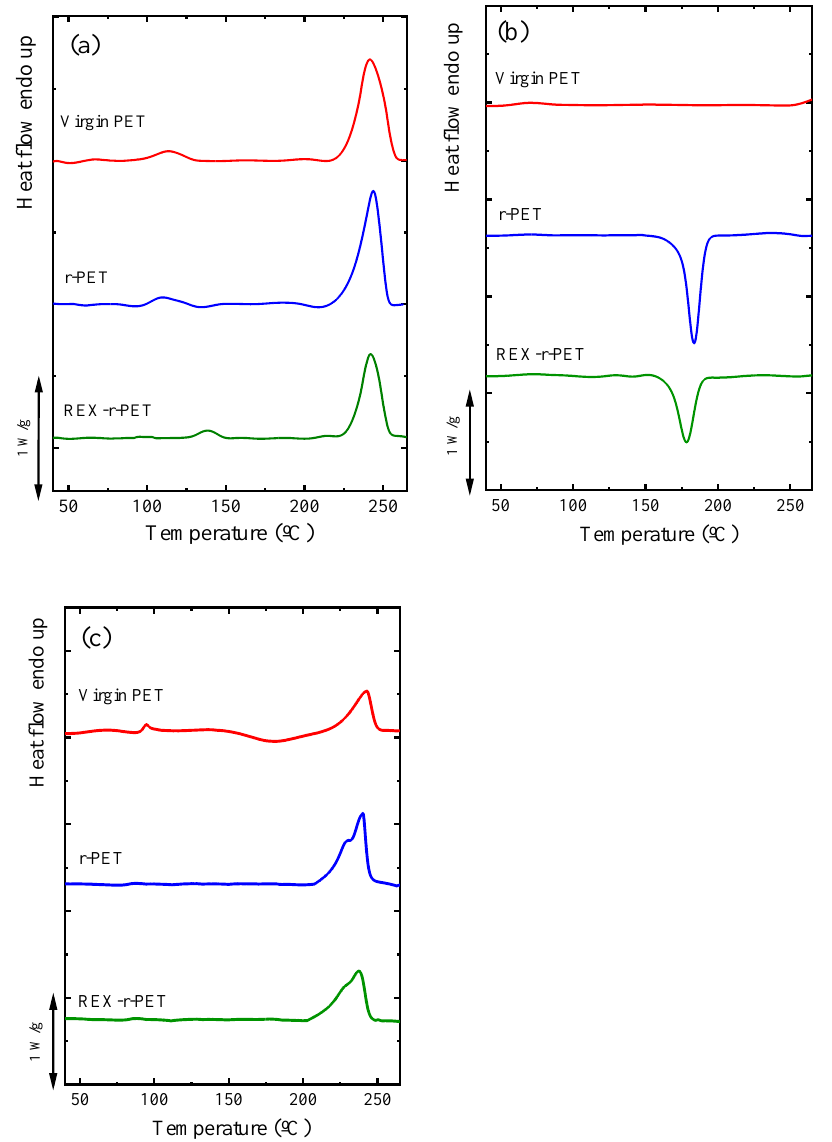
Figure 3. DSC scans of the PET samples: ( a ) first heating runs, ( b ) cooling runs from the melt, and ( c ) subsequent heating runs. Cooling and heating rates were 20 °C/min in all cases.